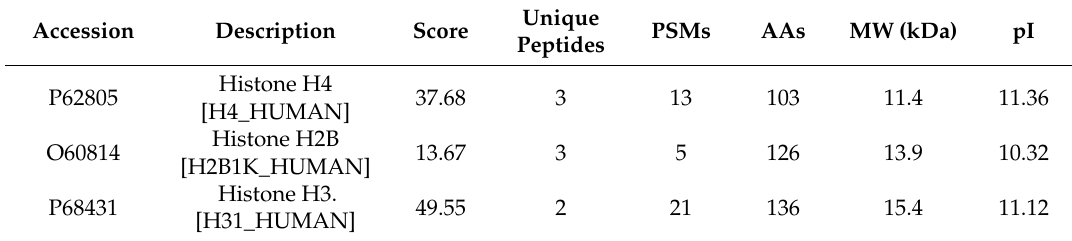
Table 2. DJ-1-interactors of particular interest. In the table are reported: Accession number, Univocal code identifying the protein on the Uniprot database (https: // www.uniprot.org); Protein description; Score for protein identification; PSMs, total number of identified peptide spectra matched for the protein; MW, molecular weight of identified protein; pI, theoretical isoelectric point of identified protein. The complete list of interactors is provided as Supplementary File